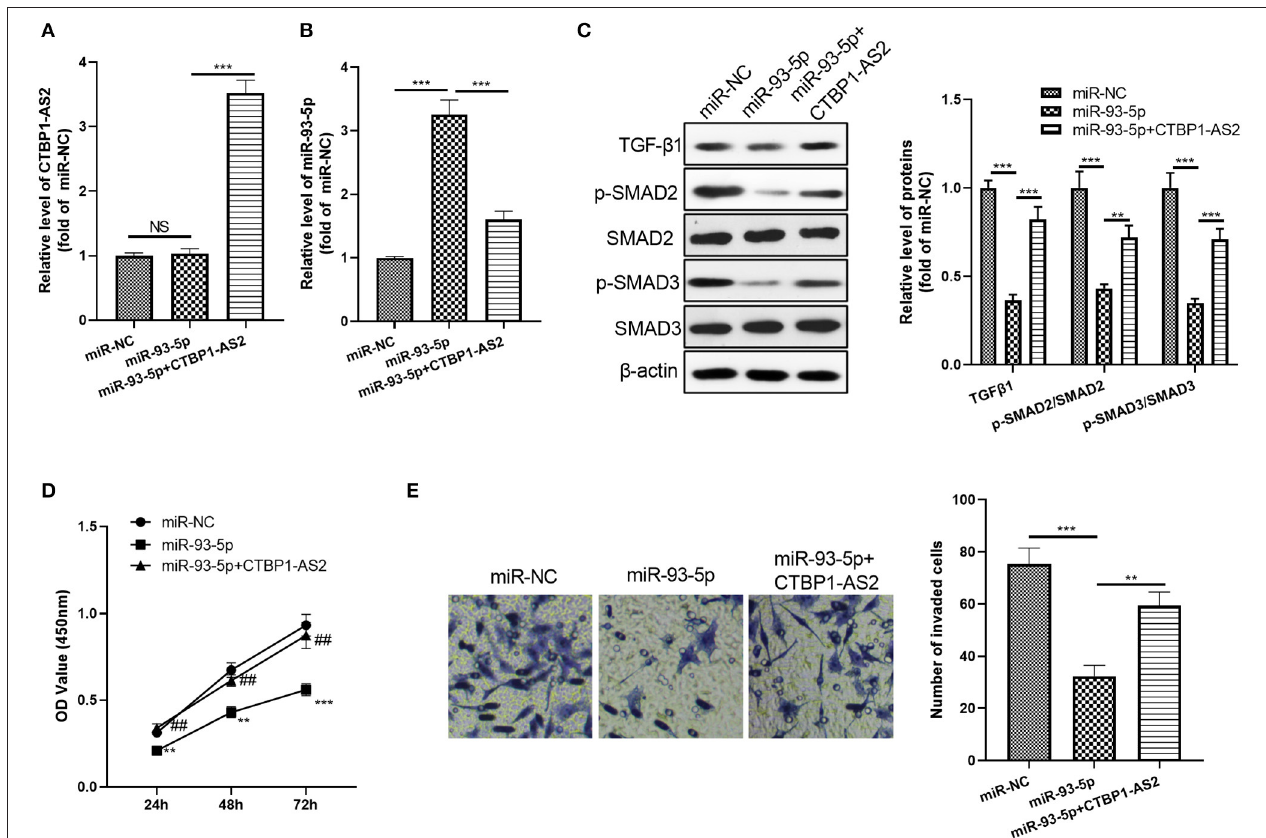
FIGURE 6 | Effect of CTBP1-AS2/miR-93-5p on CRC proliferation and invasion. (A,B) Construction of a cell model of miR-93-5p overexpression in SW620 cells, and adding CTBP1-AS2 overexpression plasmid to investigate the interaction of CTBP1-AS2-miR-93-5p axis in CRC. Use of RT-PCR to measure the levels of CTBP1-AS2 (A) and miR-93-5p (B) . (C) Detection of the levels of TGF- β 1, SMAD2, and SMAD3 in the cells by using Western blotting. (D) Use of CCK-8 to examine the cell proliferation. ** p < 0.01, *** p < 0.001 vs. miR-NC group, ##p < 0.01 vs. miR-93-5p group. (E) Use of the Transwell method to detect cell invasion. ** p < 0.01, *** p < 0.001. N = 3. CCK-8, cell counting kit-8; CRC, colorectal cancer; NC, negative control; NS, not significant; RT, reverse transcription; TGF- β , transforming growth factor- β